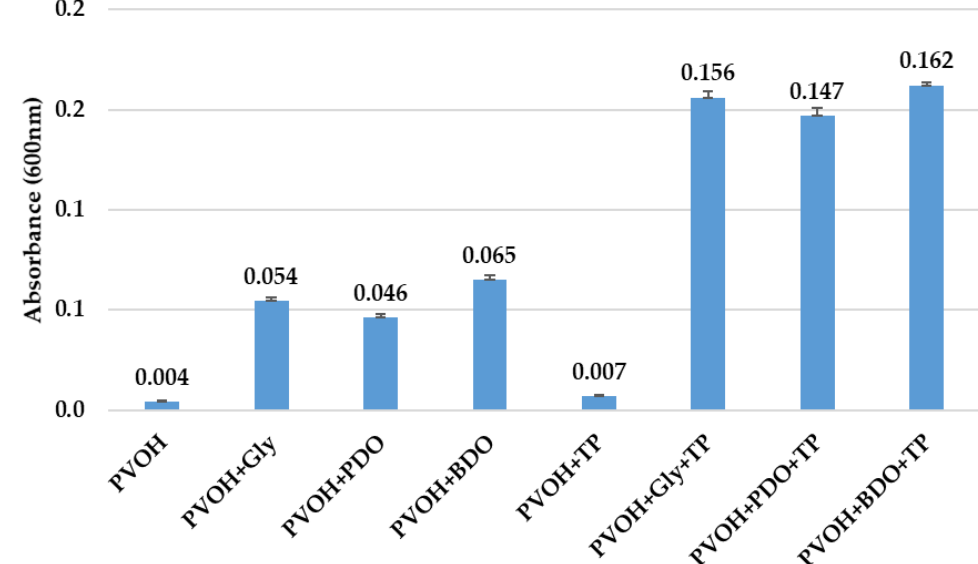
Figure 8. The UV–Vis results of PVOH-based biofilms plasticized with polyols and colored with tomato-based pigments. Reported data represents the average value of three replicates with their standard deviations (SD).